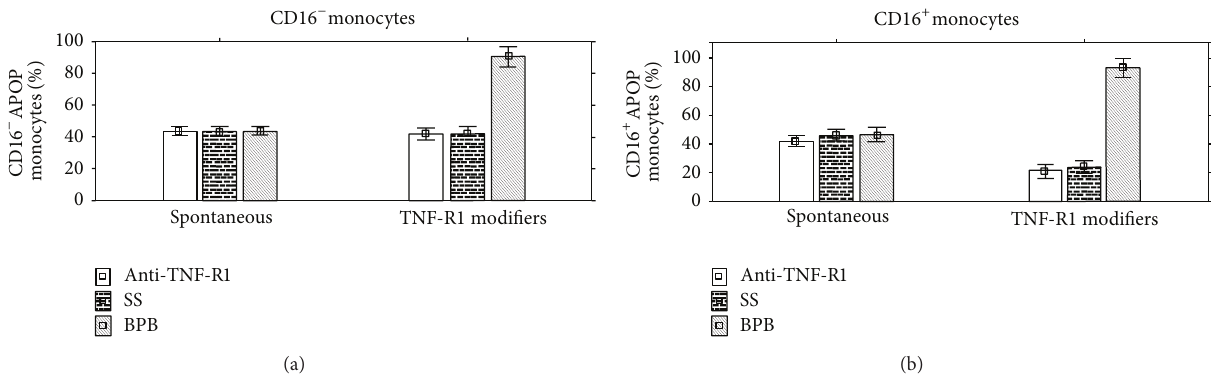
TNF-R 1 modifiers